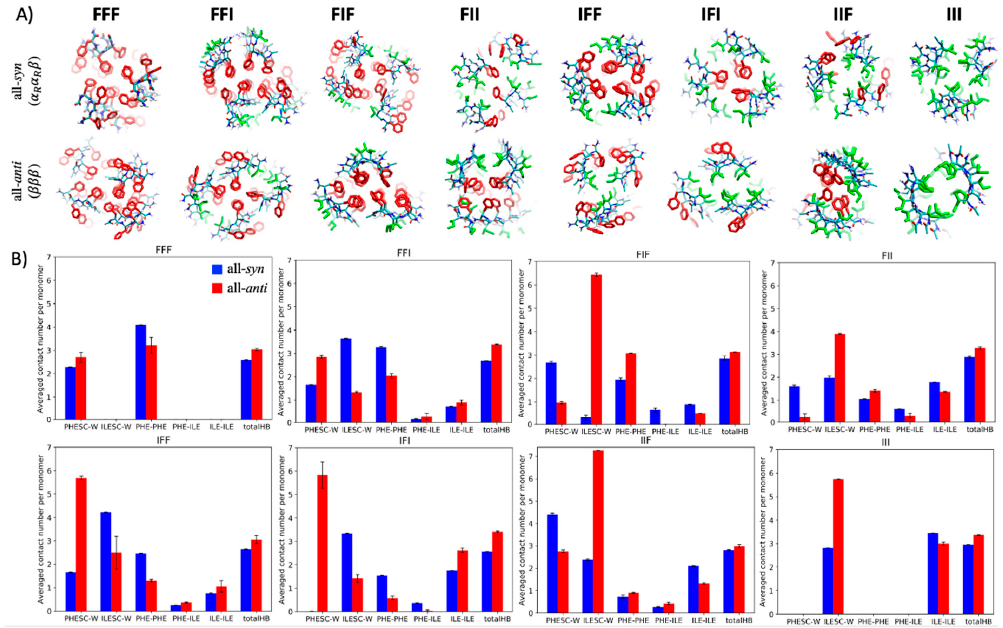
Figure 4. ( A ) Cross-sectional view of the assembled structures of tripeptides from conformationally constrained simulations. The first and the second rows show the results when the peptides were restrained in an α R α R β conformation and in a βββ conformation, respectively. The red and green sticks denote the sidechains of Phe and Ile, respectively. ( B ) Plot of noncovalent interactions that on average a single peptide was involved with in the assembled structures, including the sidechain–solvent interaction calculated as the water count around a Phe (“PHESC-W”) or Ile (“ILE-SC-W”) sidechain; the number of contacts between Phe sidechains (“PHESC-PHESC”), between Ile sidechains (“ILESC-ILESC”), and between sidechains of the two amino acid types (“PHESC-ILESC”); and the number of hydrogen bonds formed between peptide chains (“HB”). A contact was considered to be present if two particles were within 0.65 nm of each other. An HB was thought to arise if the distance between donor and acceptor atoms was <0.35 nm and the donor-hydrogen-acceptor angle was >120°. All the contact counts except for HBs were per-residue-based. Strictly speaking, π – π interactions involve the contacts of Phe aromatic rings that exhibit special relative orientations, but here we used the contact count (“PHESC-PHESC”) as an approximate estimate to assess the extent of the π – π interactions. Only those peptides within 1 nm of the centroid of fibrous segments were considered in the calculation. The blue and red bars denote results obtained from the simulations when the peptides were restrained in α R α R β or βββ , respectively.